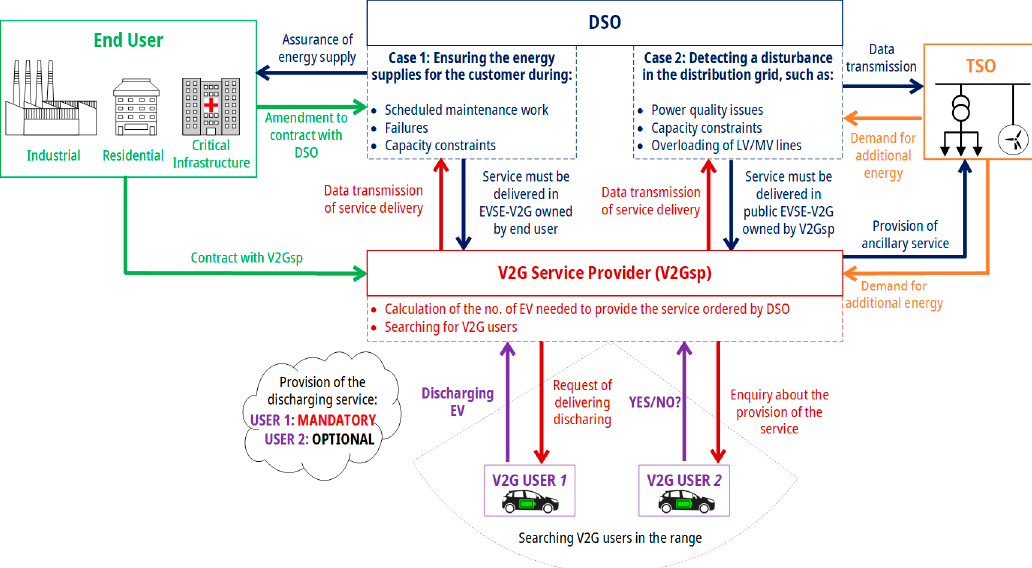
Figure 3. Relations between actors in V2G Program.